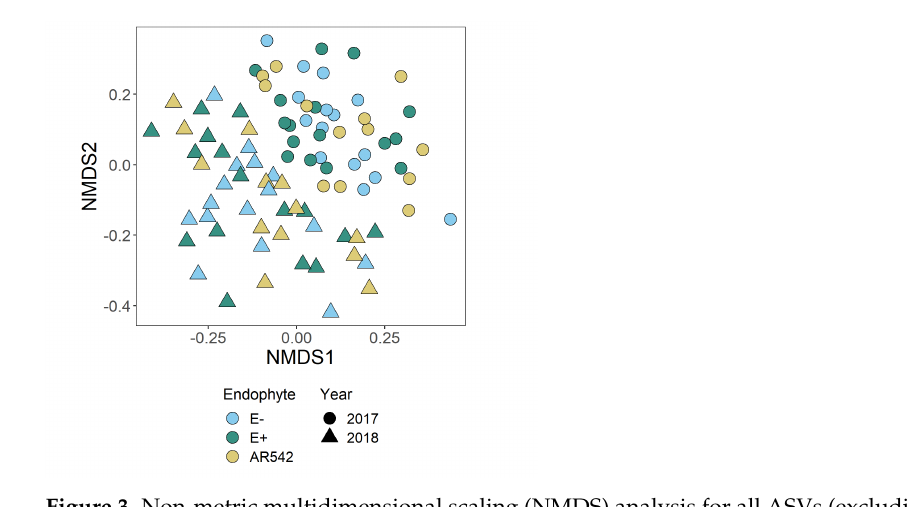
Figure 3. Non-metric multidimensional scaling (NMDS) analysis for all ASVs (excluding Epichloë ). There is strong separation by year, but a great deal of overlap between the Epichloë